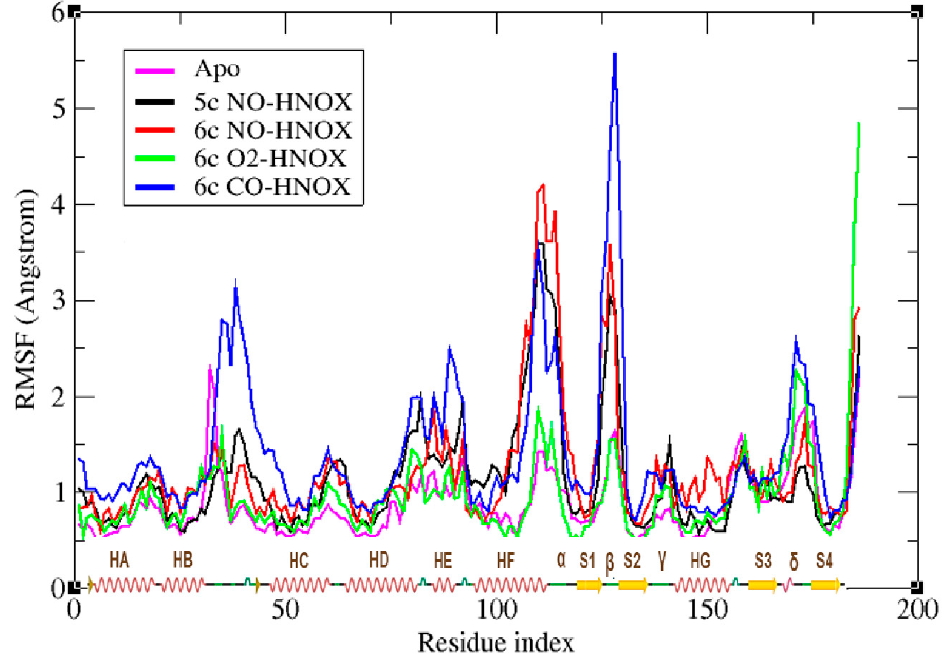
Figure 4. The plot depicts the residual fluctuations of human HNOX domain (1–186 a.a.) under the influence of gaseous ligands NO, O 2 and CO. The x-axis shows the residue number, as well as the secondary structure elements of the H-NOX domain; helices are represented as red springs (HA, HB, HC, HD, HE, HF, HG), loops as green lines ( α , β , γ , δ ), and strands as yellow arrows (S1, S2, S3, S4). The y-axis represents the residual mobility around its mean position. Magenta, black, red, green, and blue represent the RMSD plots of apo, 5c NO-HNOX, 6c NO-HNOX, 6c O 2 -HNOX and 6c CO-HNOX, respectively.